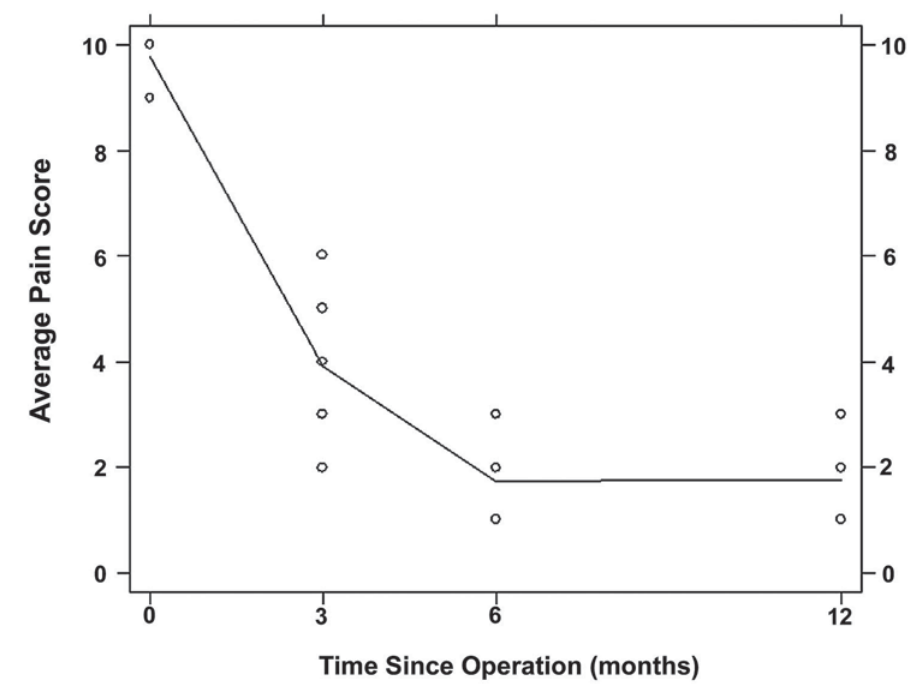
Figure 5 – Plot of average pain score versus follow-up time in months, showing data spread at each time